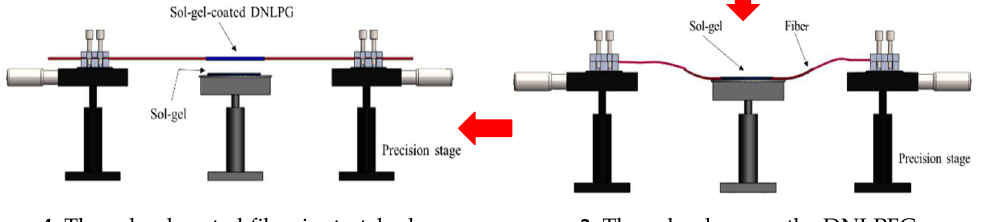
Figure 3 . Production flow chart of sol-gel coated DNLPFG sensor.